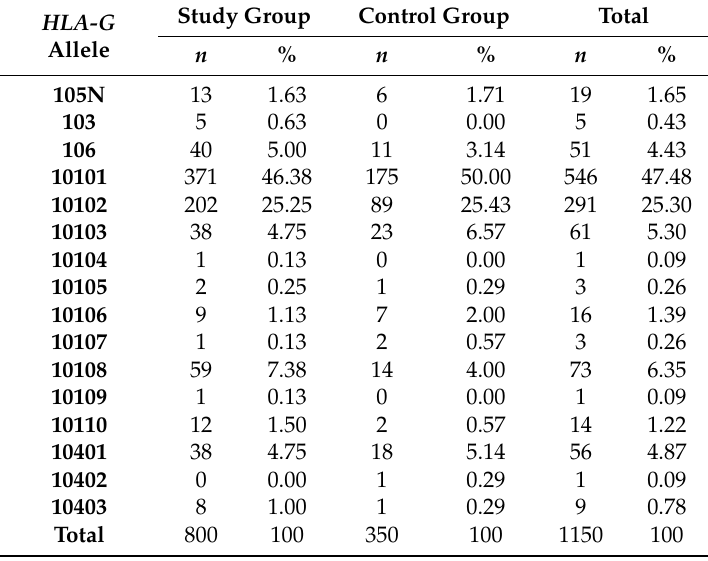
Table 3. The frequency of the HLA-G alleles in the experimental and the control